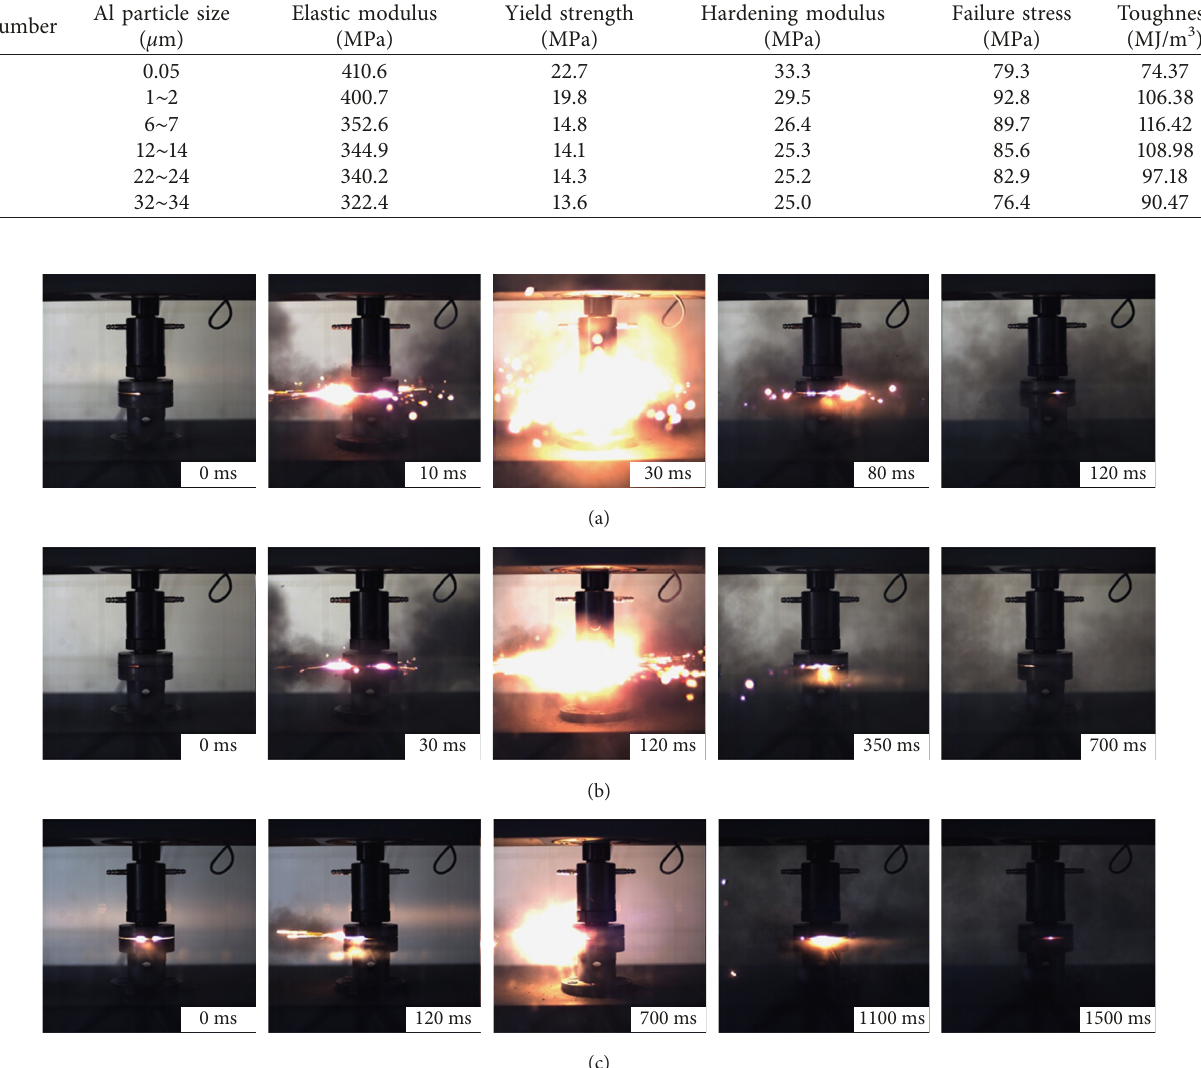
Table 1: Mechanical properties of specimens #1–#6 under quasistatic